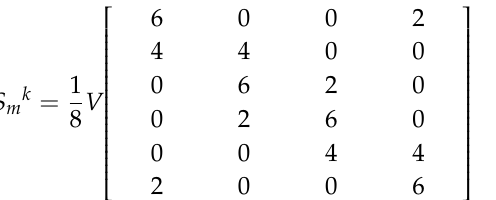
Figure 2. Part for ( left ) HP pattern and ( right ) HT pattern.